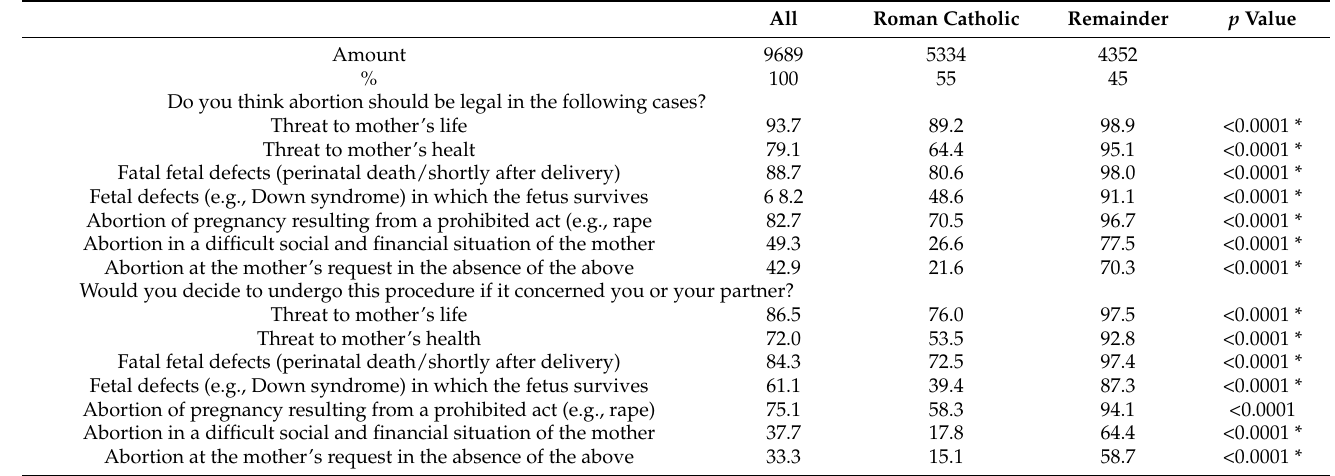
Table 3. Attitude to abortion regarding religion. All data contained in table are presented as percentage [%] of answers YES for each